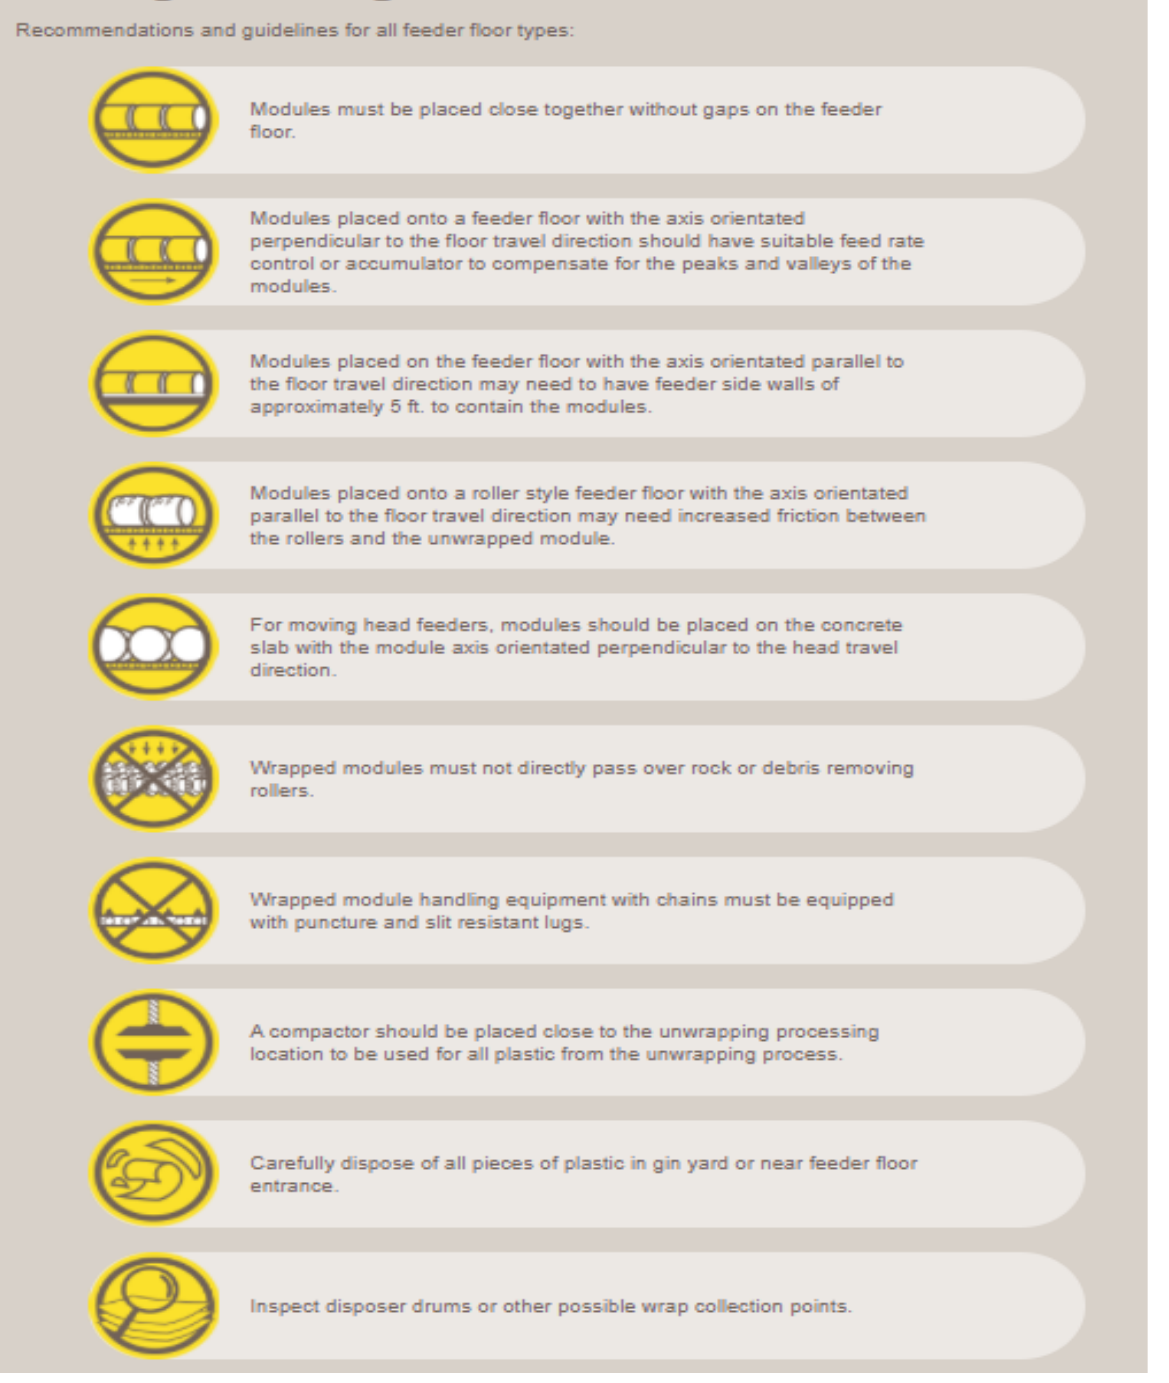
Figure A1. Round module cover manufacturer recommendations and guidelines for handling round seed cotton modules at gins to minimize plastic contamination (adapted from [63]).